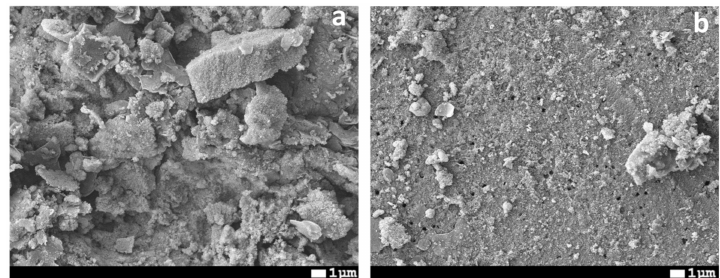
Figure 11. SEM images of PET-Si-F membrane surface (pore diameter is 263 nm) just after DCMD ( a ) and after washing in warm water ( b